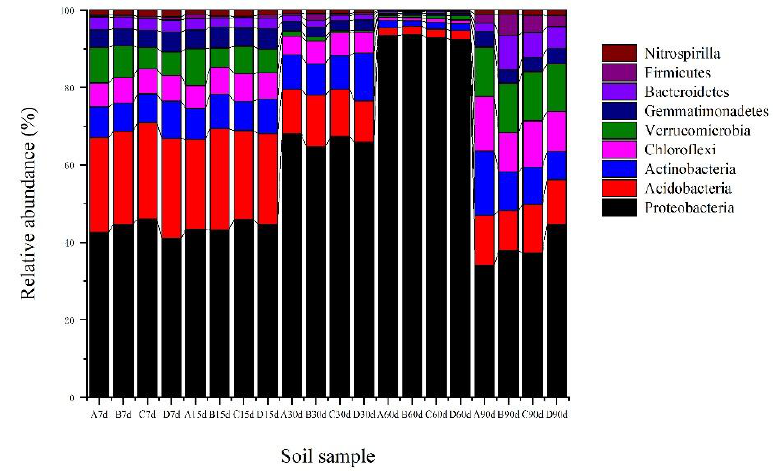
Figure 5. Statistics of the soil bacterial groups at different taxonomic levels. (A: 0 mg kg −1 ; B: 10 mg kg −1 ; C: 100 mg kg −1 ; D: 1000 mg kg −1 ; 7, 15, 30, 60, and 90 d mean 7, 15, 30, 60, and 90 days, respectively).